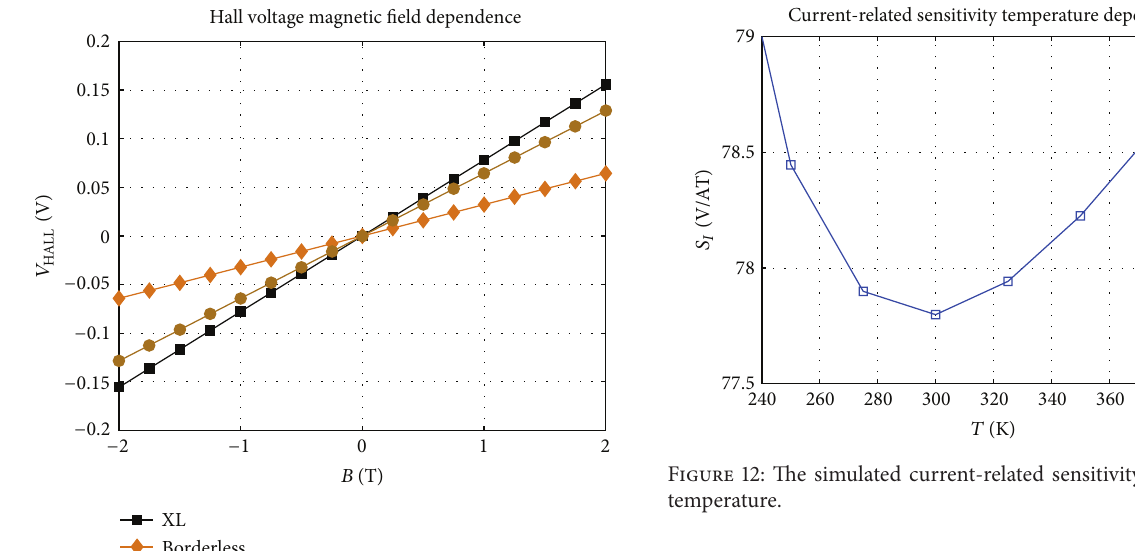
versus the magnetic HALL